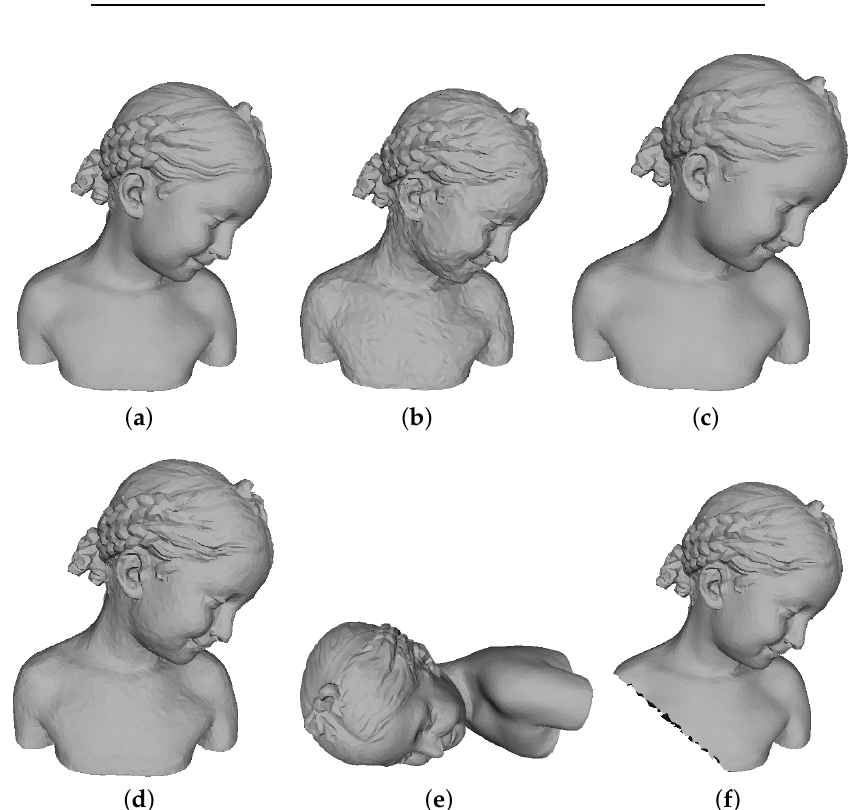
Figure 11. Original Bimba and seven attack versions: ( a ) the original Bimba; ( b ) a noise addition of 0.50%; ( c ) a smoothing of λ = 0.1 with 5 iterations; ( d ) a quantization of 9 bits; ( e ) similarity transformation; and ( f ) a cropping ratio of